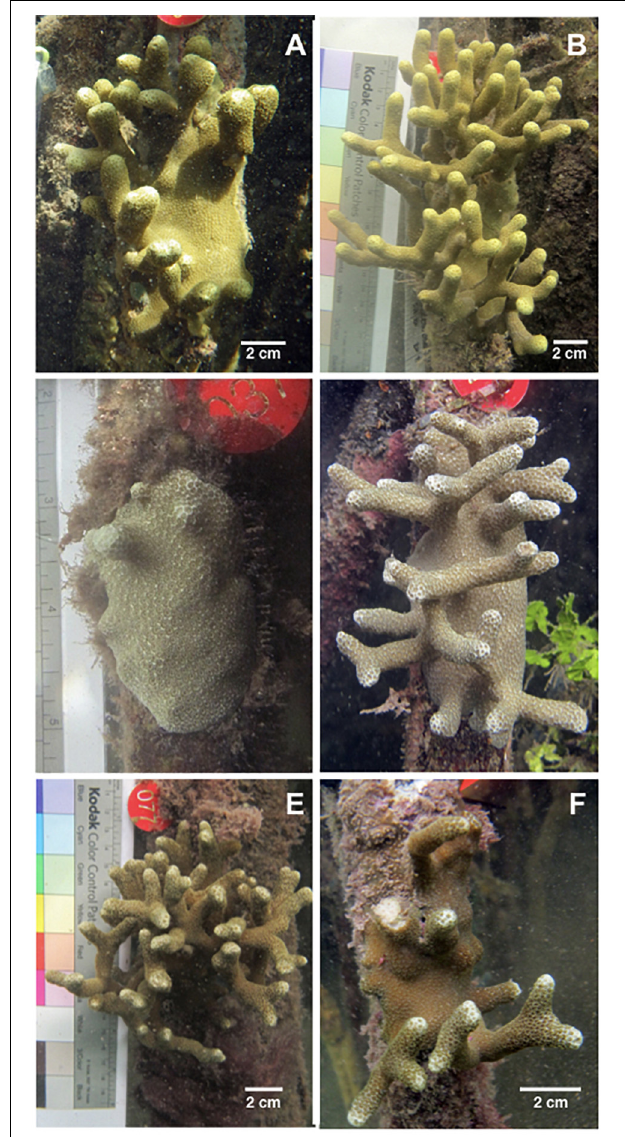
FIGURE 6 | Examples of colony growth and shrinkage. (A) Colony #97 in 2015. (B) The same colony in 2016 after adding 35 branch tips and increasing 1084 cm 3 in ecological volume. (C) Colony #37 in 2016. (D) The same colony in 2017 after adding 23 branch tips and increasing 326.7 cm 3 in ecological volume. (E) Colony #77 in 2016. (F) The same colony in 2017 after losing 32 branch tips and decreasing by 1798.8 cm 3 in ecological volume. Of note, the three colonies shown here vary in color, and the general hue of each coral remains constant from